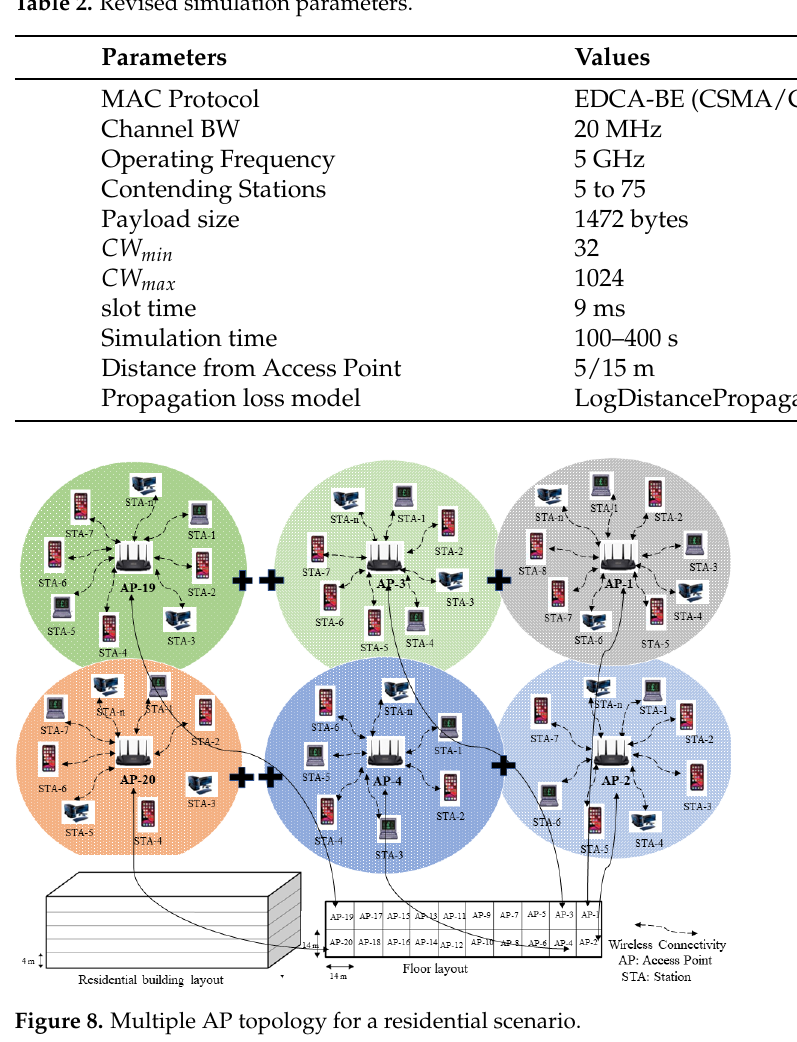
Table 2. Revised simulation parameters.